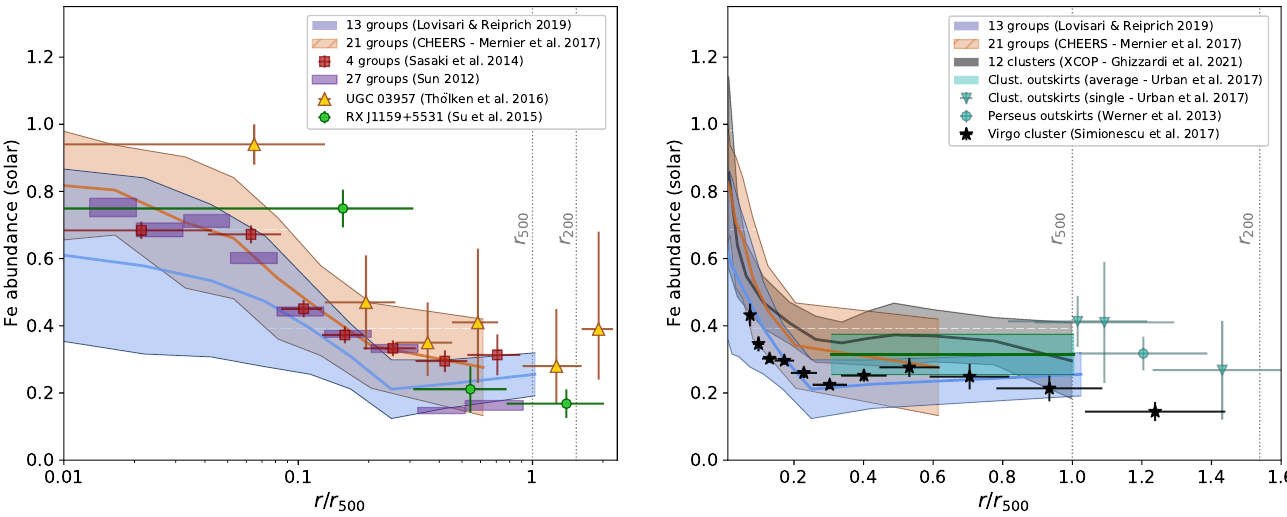
Figure 4. Fe abundance radial profiles in various galaxy groups (and clusters) from the literature. ( Left ) The recent average profiles of (Reference Mernier et al. [89], the 21 CHEERS groups) and (Reference Lovisari and Reiprich [52], 13 groups— excluding systems overlapping with the CHEERS observations) are compared with those of (Sasaki et al. [75], 4 groups) and (Sun [33] 27 groups—below kT 500 = 1.9 keV), as well as with independent measurements of UGC03957 [86] and RXJ1159+5531 (Reference [77], azimuthally averaged). ( Right ) The same two average group profiles are compared with measurements of more massive systems—i.e., the XCOP sample (Reference [9], 12 clusters), the Fe abundance in cluster outskirts (Urban et al. [102], with averaged and single measurements shown, respectively, below and beyond r 500 —also including the outermost Perseus value from Werner et al. [101]), as well as the (azimuthally averaged) profiles of the Virgo cluster [105]. For consistency, the scatter envelope of the samples of Urban et al. [102] and Lovisari and Reiprich [52] have been computed following that of the CHEERS sample Mernier et al. [89]. All measurements have been re-scaled into radial units of r 500 (following the values given in the corresponding papers and/or the conversion proposed by Reference [106]) and into Solar units of Asplund et al.